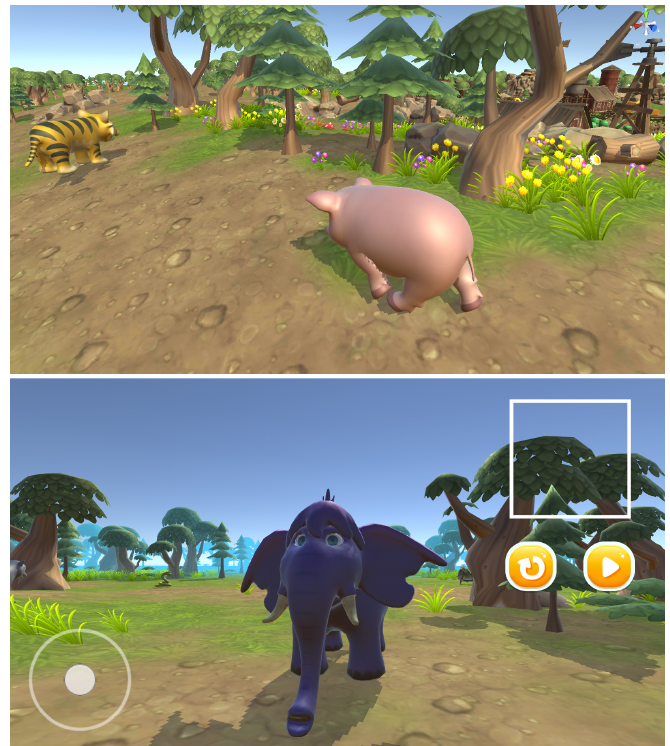
Figure 5. Composition of scenes in the English language teaching application [33–35].